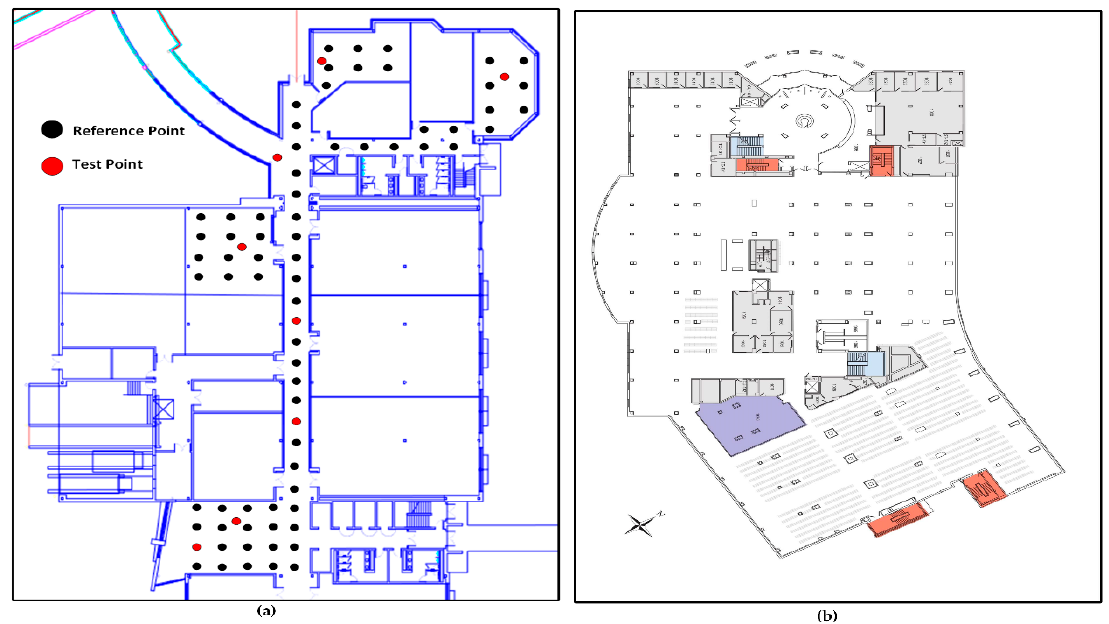
Figure 9. The map of the area of interest at Western Michigan University. ( a ) CEAS building; ( b ) waldo Library building.